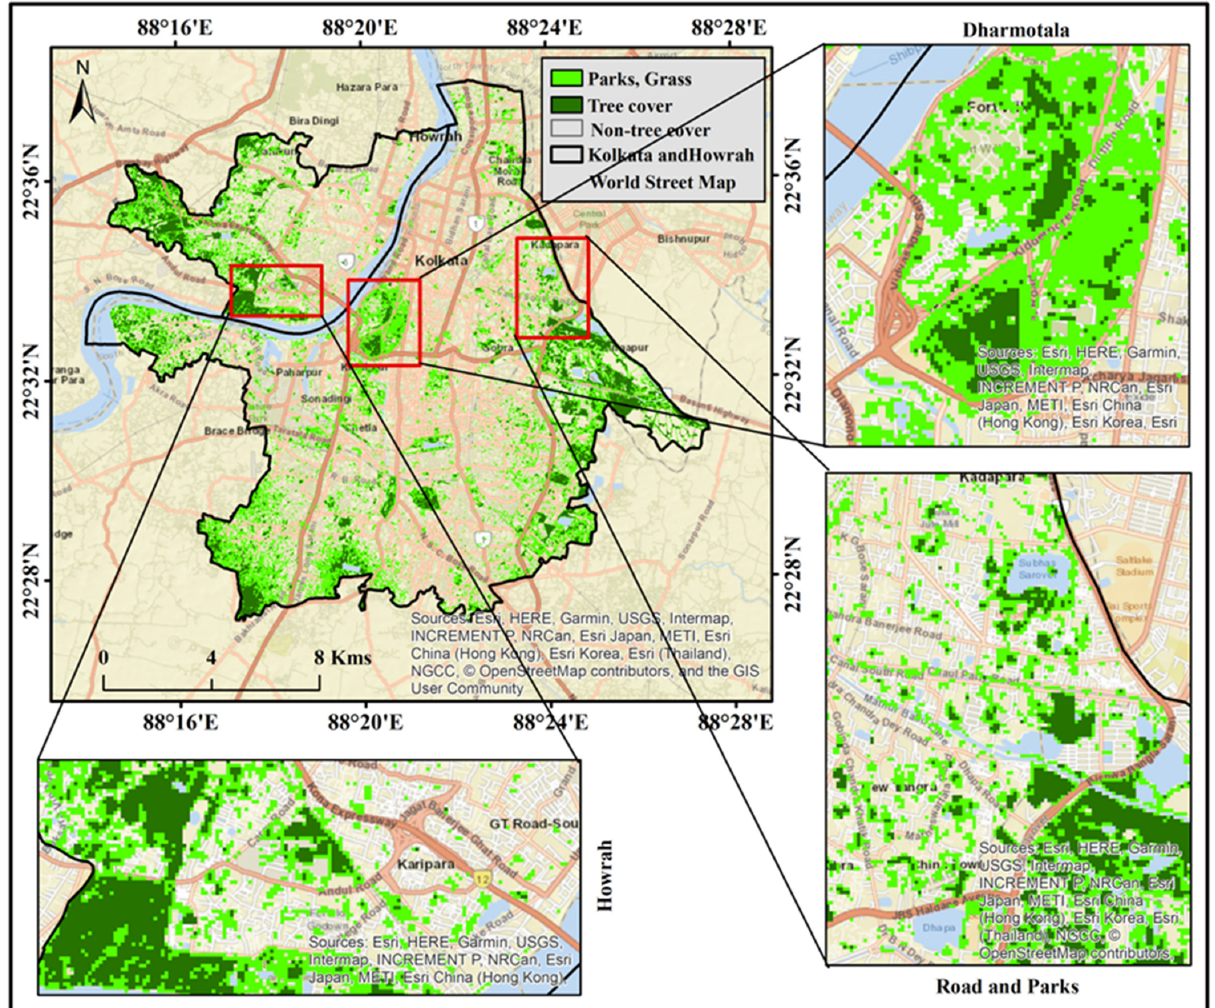
Figure 12. Recent zone ‐ wise green space and grassland of West Bengal (Kolkata and